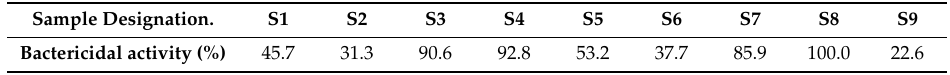
Figure 4. Bacterial colonies evaluate the bactericidal activity of CAPJ operating parameters. Photos of bacterial colonies of control S0 and CAPJ treated samples ( S1 ) to ( S9 ) with a combination of different Taguchi experimental parameters. The visualized colonies grew on the LB agar plates and were counted and represented in CFU as tabulated in Table 4. Table 4. The bactericidal activity of E. coli by nine different CAPJ treatments.